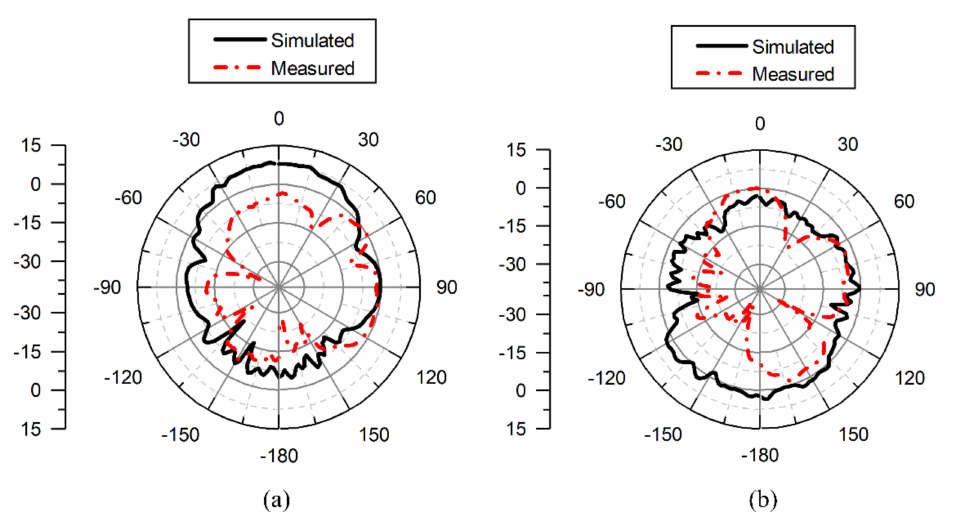
Figure 15. Radiation pattern for the high-band MIMO antenna: ( a ) measured and simulated radiation pattern for phi = 90 ◦ at 27.5 GHz; ( b ) measured and simulated radiation pattern for theta = 90 ◦ at 27.5